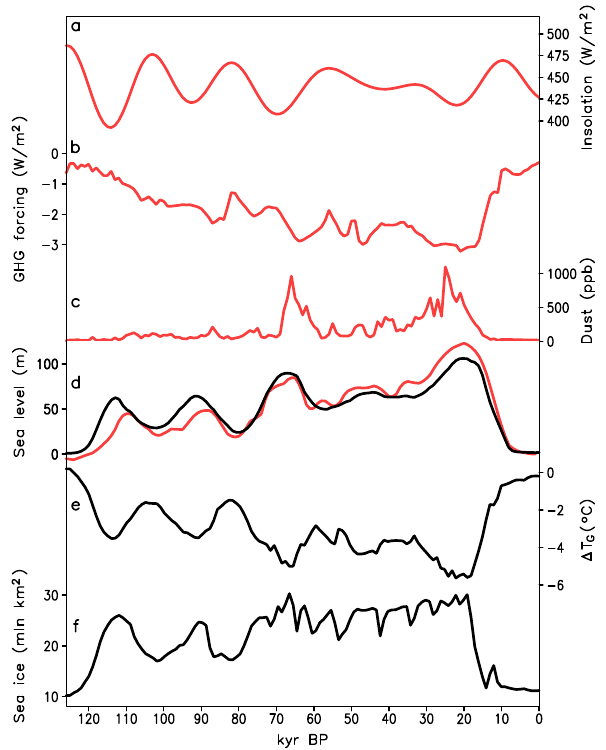
Fig. 1. Prescribed forcings and results of physical model simula- tion of the last glacial cycle. (a) Orbital forcing (illustrated by the June insolation at 65 ◦ N); (b) radiative forcing of GHGs, (c) con- centration of dust in the EPICA ice core; (d) changes in the simu- lated ice sheet volume (thick black line) and reconstructed sea level change (Waelbroeck et al., 2002) (thin red line), in meters of sea level change relative to 126kyrBP; (e) changes in the simulated global surface air temperature; (f) simulated annual mean sea ice area in the Southern